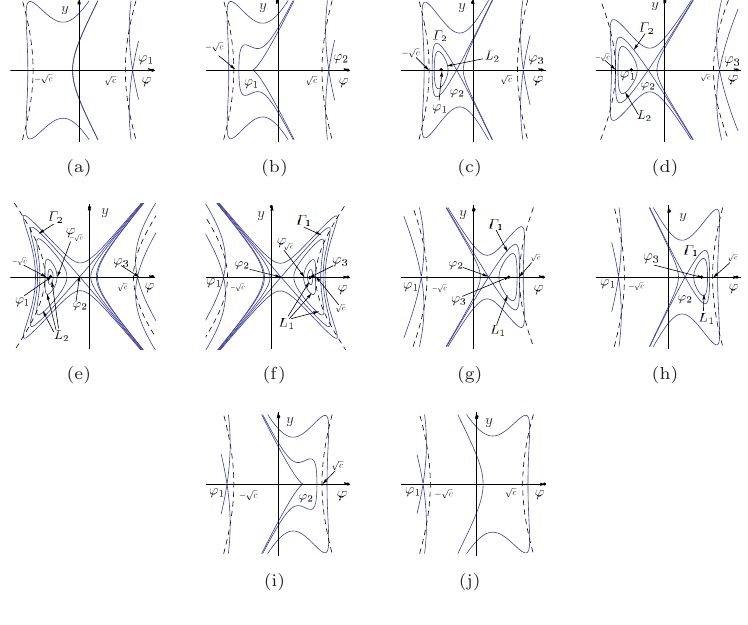
Figure 3. The bifurcation phase portraits of systems (2.3) and (2.4) with c > 0 and g 6 = 0: (a) g < − 2 c 3 q c 3 ; (b) g = − 2 c 3 q c 3 ; (c) − 2 c 3 q c 3 < g < − 8 c √ c − 8 c 27 < g < 0; (f) 0 < g <